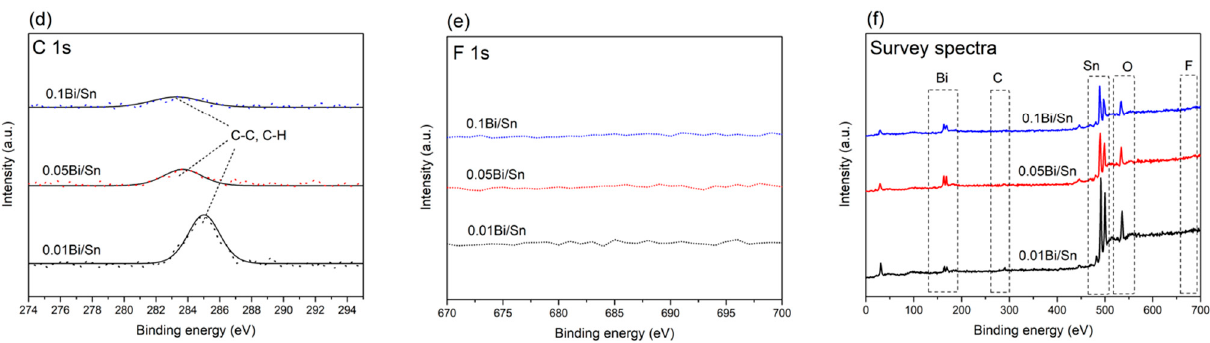
Figure 2 . XPS spectra of ( a ) Bi 4f, ( b ) O 1s, (c ) Sn 3d, ( d ) C 1s, ( e ) F 1s, and ( f ) survey spectra of Bi/Sn electrodes.